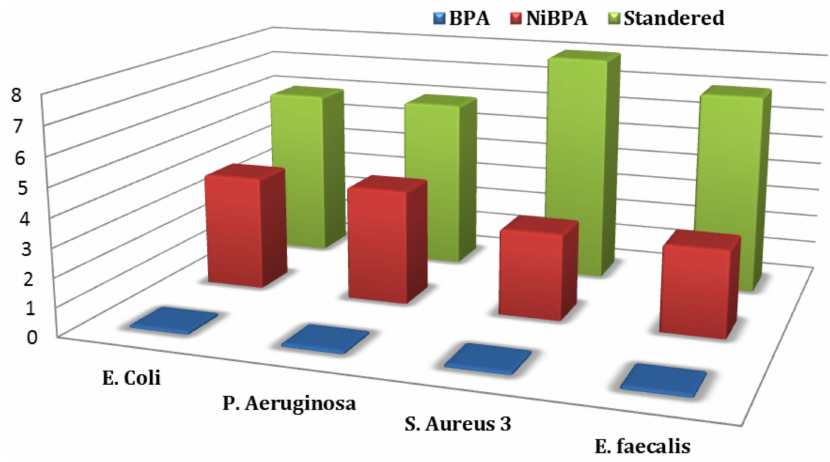
Figure 11. Mean inhibition zone of BPA, NiBPA, and standard against Gram-negative ( E. coli and P. aeruginosa) and Gram-positive ( S. aureus and E. faecalis) bacteria (mm) compared to